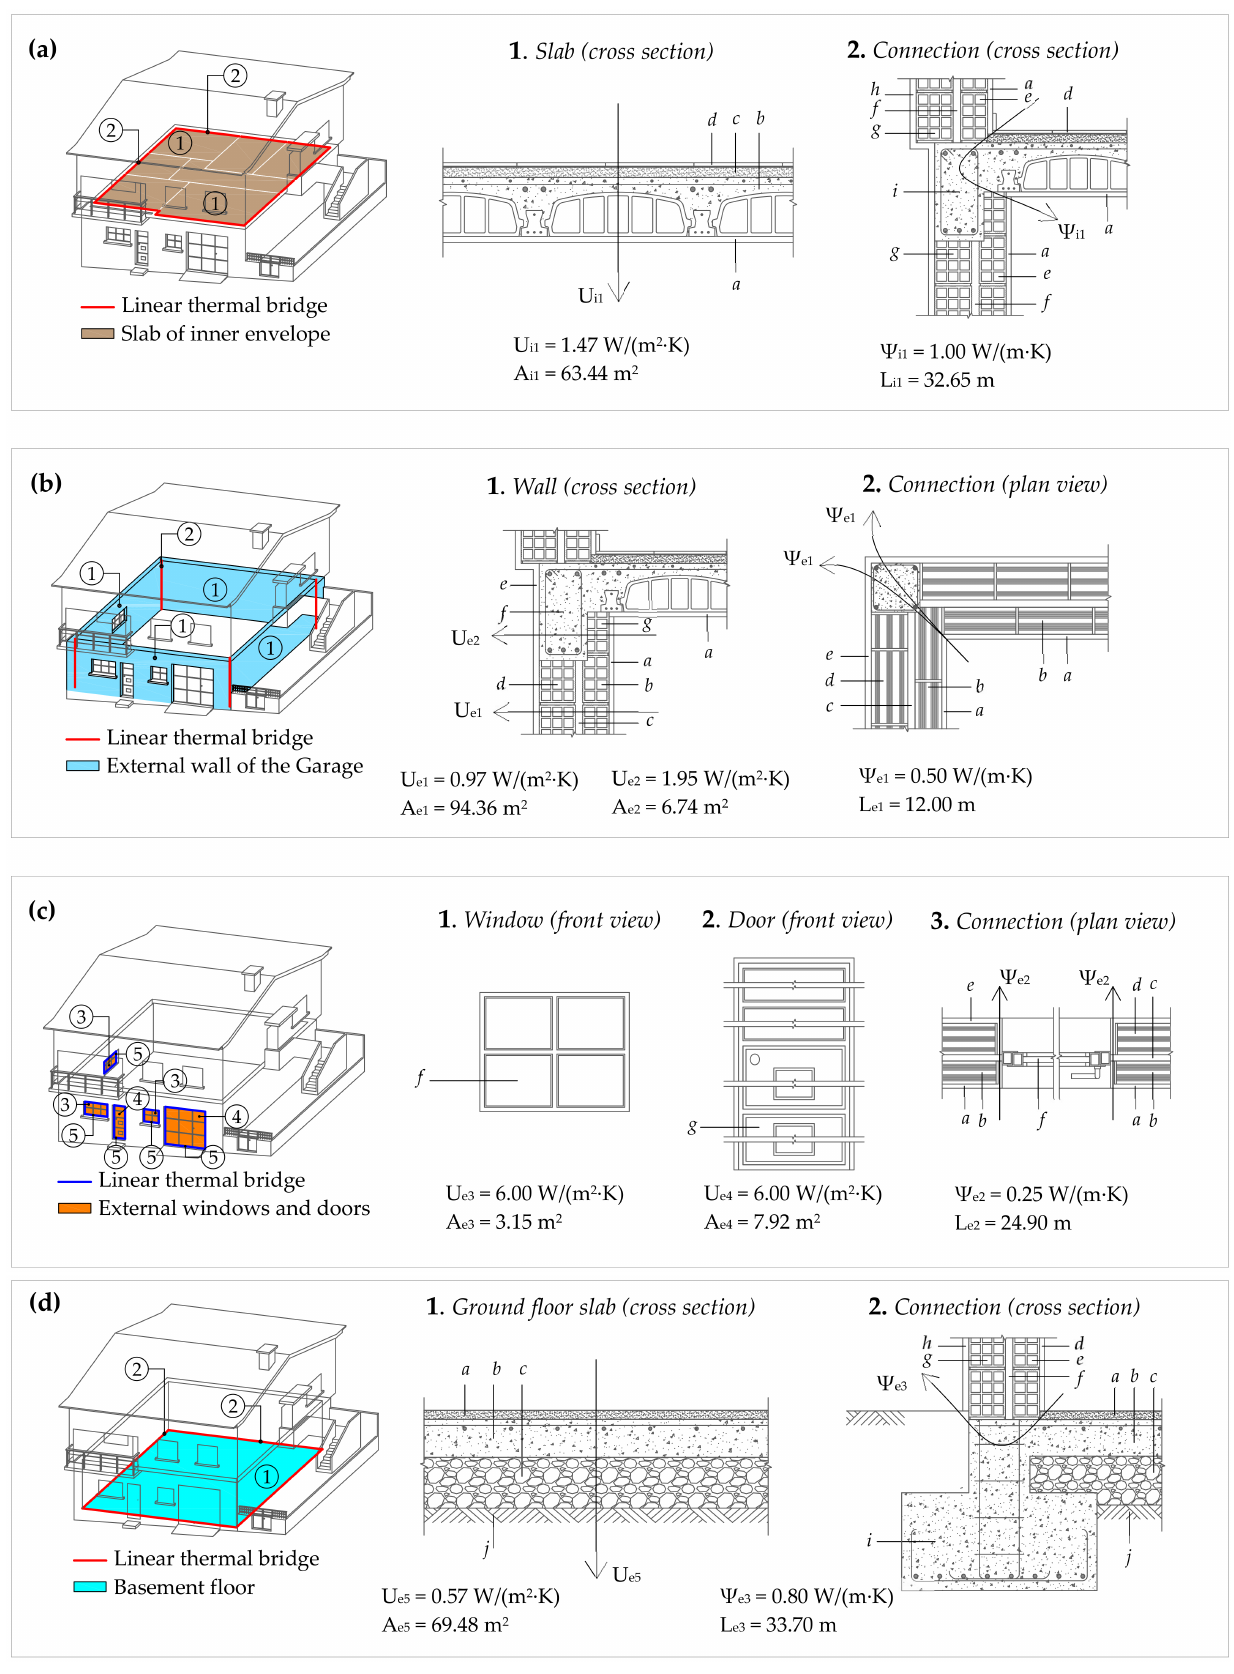
Figure 6. Characterization of the thermal envelope of Garage 1: ( a ) slab separating INT from